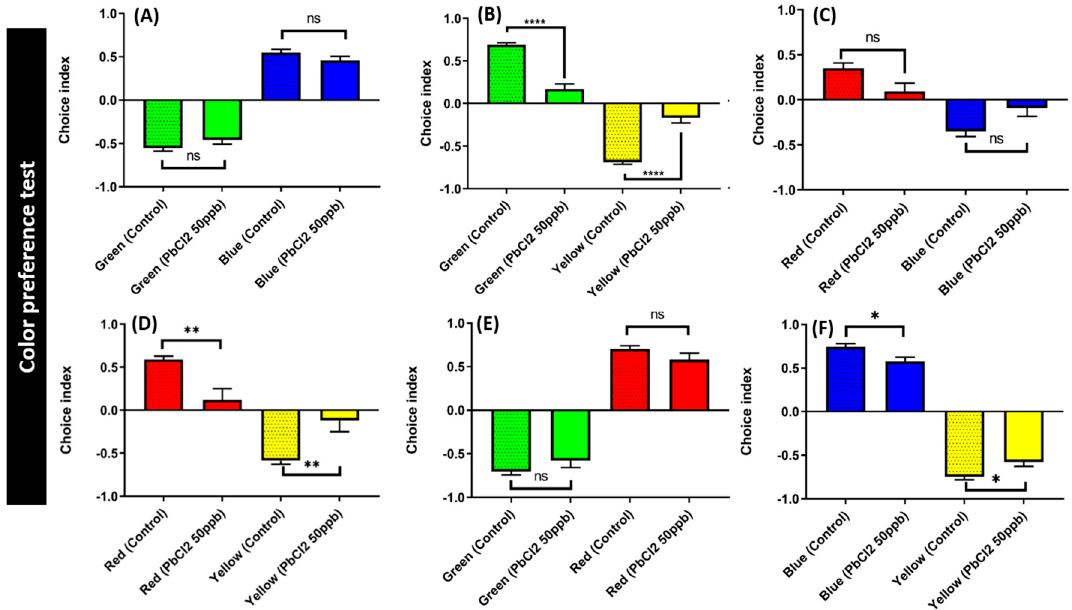
Figure 8. Comparison of the color preference between control and PbCl 2 -exposed fish (50 ppb for 30 days). The combinations of four colors are ( A ) green / blue, ( B ) green / yellow, ( C ) red / blue, ( D ) red / yellow, ( E ) green / red, and ( F ) blue / yellow. Data are expressed as mean ± SEM values and analyzed by two-way ANOVA ( n = 16; * p ≤ 0.05, ** p ≤ 0.01, **** p ≤ 0.0001).